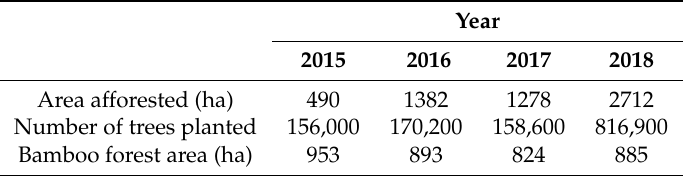
Table 1. Forest change of Chongming island from 2015–2018. These data are sourced from the Chongming Statistical Yearbook published by the Chongming Statistical Bureau [39–42]. It is worth noting that at the time of this paper’s completion, the Chongming Statistics Bureau had not yet released the 2019 data.